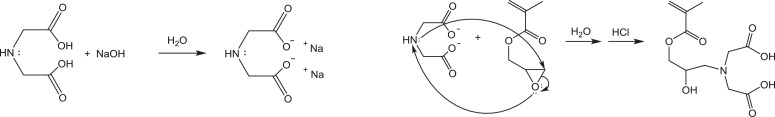
Mechanism for the synthesis of monomer 1: glycidyl methacrylate-iminidiacetic acid (GMA-IDA) beginning with a neutralization of iminodiacetic acid (left) followed by an epoxy ring opening to join GMA and IDA together (right).